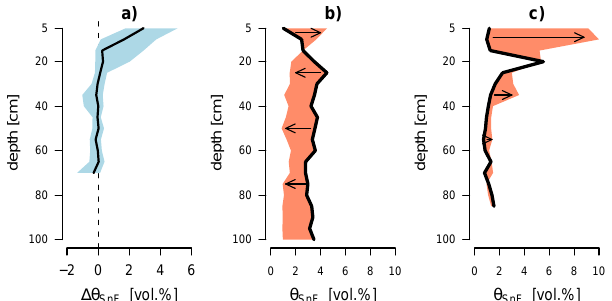
Fig. 8. (a) Difference between morning and afternoon liquid water content ( θ SnF ), measured in 33 locations. Positive values indicate content ( θ SnF ), measured in 33 locations. Positive values indicate an increase in θ SnF from morning to afternoon. Depth is given in cm an increase in θ SnF from morning to afternoon. Depth is given in below snow surface. The median is the bold line, the shaded area cm below snow surface. The median is the bold line, the shaded area represents the interquartile range. (b) and (c) example of profiles represents the interquartile range. b) and c) example of profiles with significant changes in θ SnF during the day. The bold line represents with significant changes in θ SnF during the day. The bold line rep- the morning measurements (median of 3), the shaded area and the resents the morning measurements (median of 3), the shaded area arrows indicate the change during the day. and the arrows indicate the change during the day.